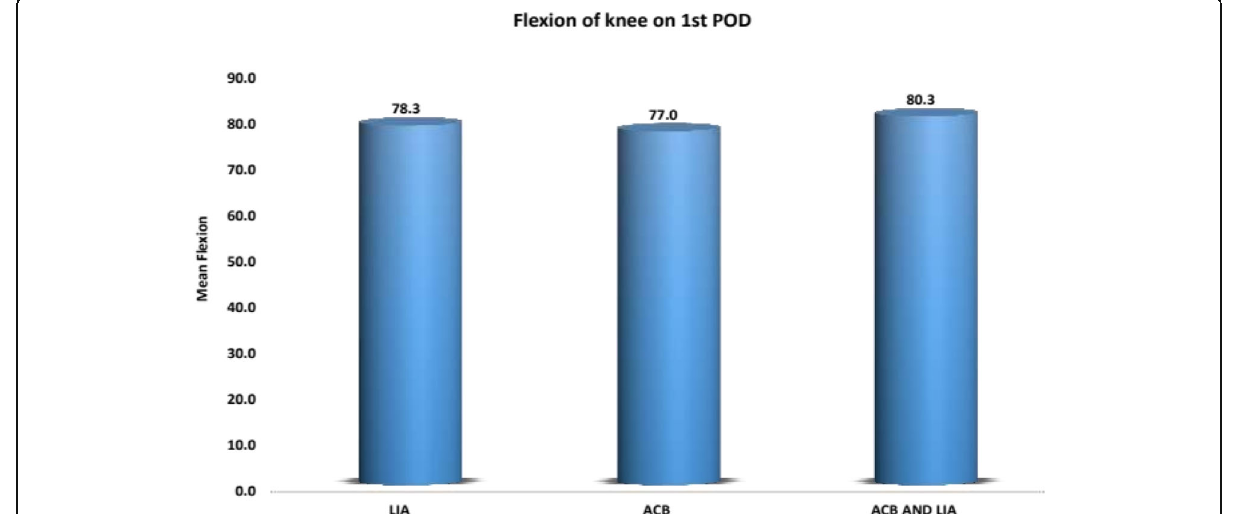
Fig. 6 Flexion of knee on the 1st POD (post-operative day)